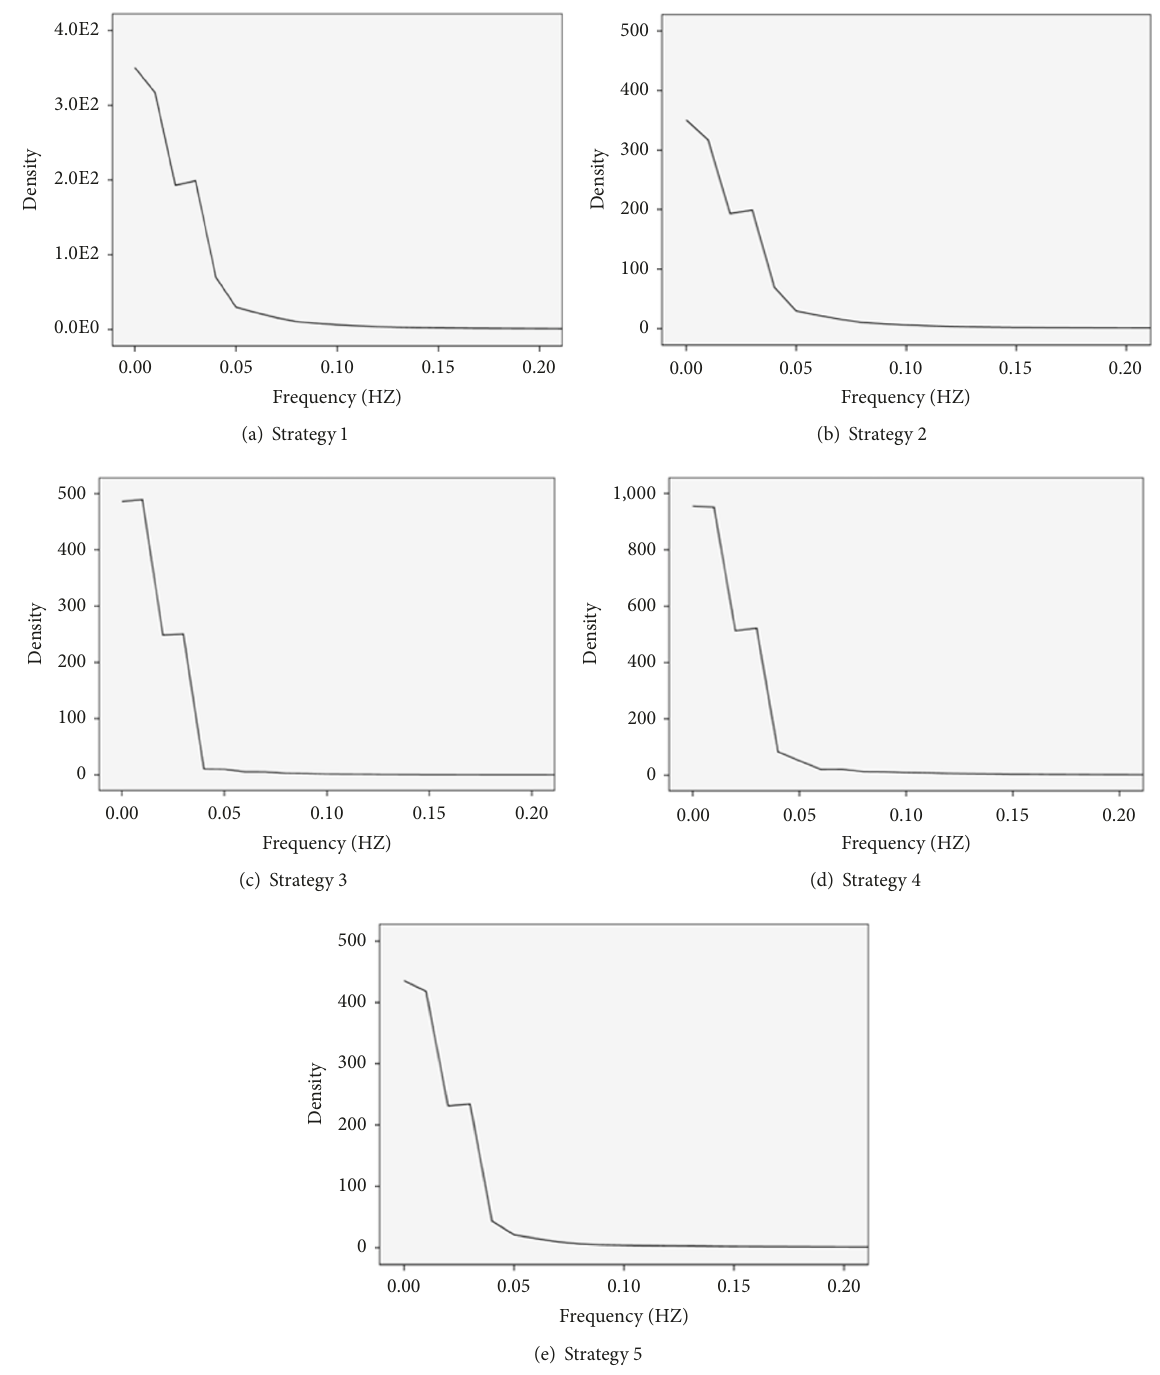
Figure 6: Frequency spectra of the driver’s